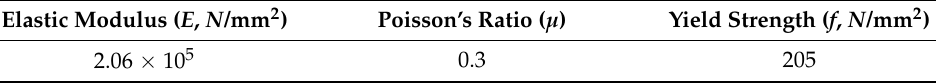
Table 8. Steel pipe material parameters.